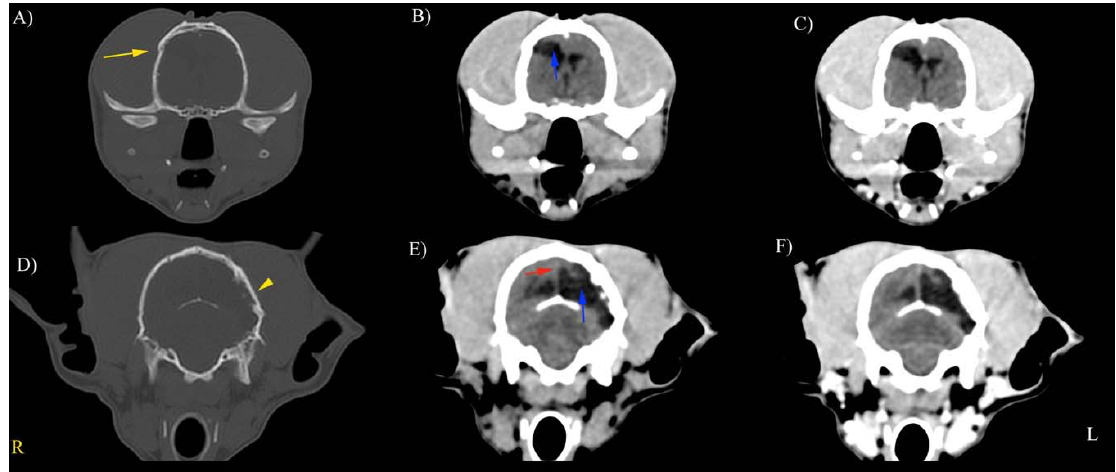
Figure 3. Representative precontrast ( A – E ) and postcontrast ( C , F ) CT scans in a red fox with soft tissue reconstruction kernel and WW (100) WL (50) for the brain (A). Bone reconstruction kernel and WW (1500) WL (300) for bone tissue. Site of fracture (yellow arrow). Ventricles were asymmetrically distended (blue arrow); mild midline shift (red arrow). Right ( R ) on the left of the image, left ( L ) on the right of the image.